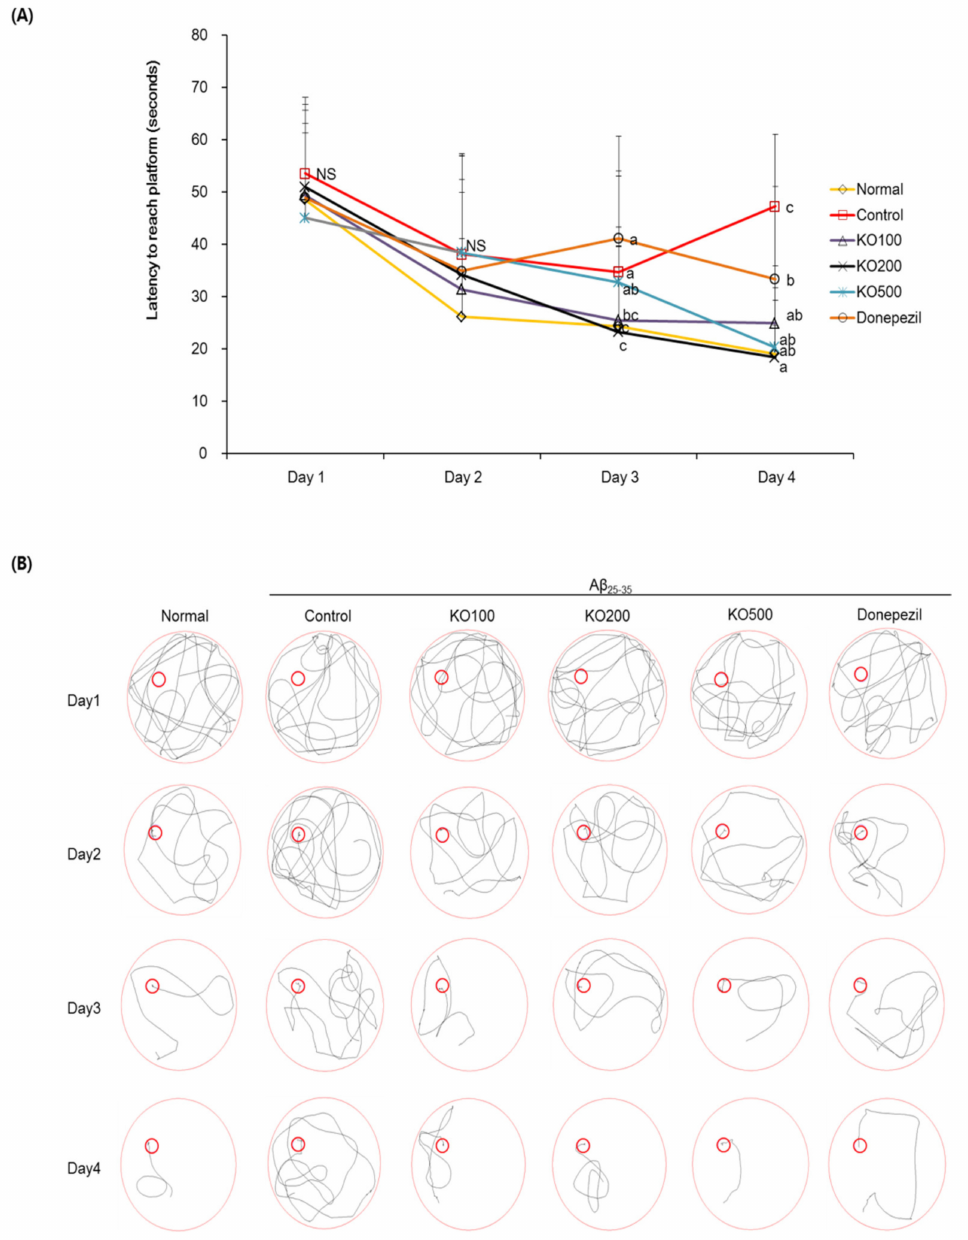
Figure 4. E ff ects of krill oil (KO) on escape latency to the hidden platform in the Morris water maze test ( A ). Path tracing of each groups in the Morris water maze test ( B ). Normal, injection of saline solution + oral administration of water; Control, injection of A β 25–35 + oral administration of water; KO100, injection of A β 25–35 + oral administration of KO at 100 mg / kg / day; KO200, injection of A β 25–35 + oral administration of KO at 200 mg / kg / day; KO500, injection of A β + oral administration of KO 25–35 at 500 mg / kg / day; Donepezil, injection of A β 25–35 + oral administration of donepezil at 5 mg / kg / day. Values are represented as means ± SD ( n = 8). a–c Means with the di ff erent letters are significantly di ff erent ( p < 0.05) by Duncan’s multiple range test. NS, non-significance. a,b Means with the same letters such as a and b are not significantly di ff erent ( p < 0.05) by Duncan’s multiple range